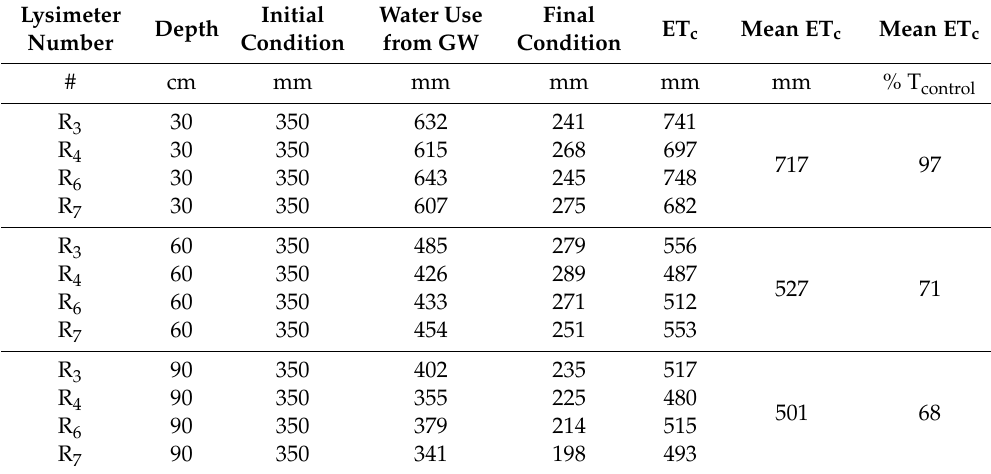
Table 3. Total canola water use from the groundwater for di ff erent